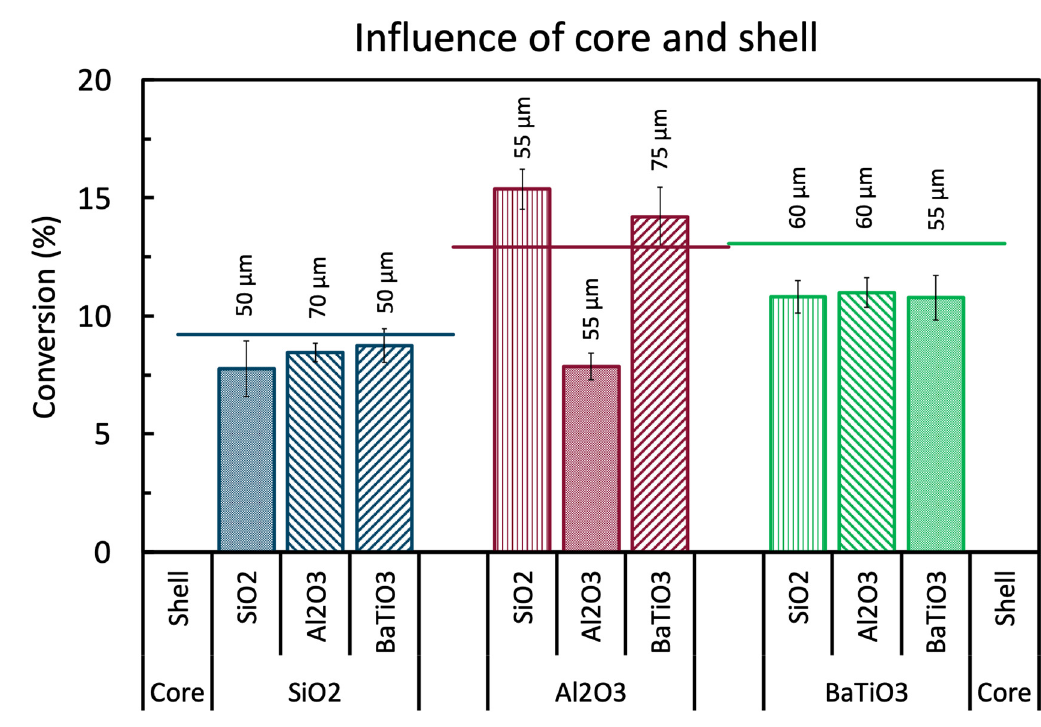
Figure 2. Influence of the core and shell material tested by approximately 50 µm thick shells applied on different core materials. All samples are compared to the pure spheres (solid line) with 1.6 to 1.8 mm size. All experiments are performed at the standard conditions. The exact values can be found in Table A1 in the appendix.